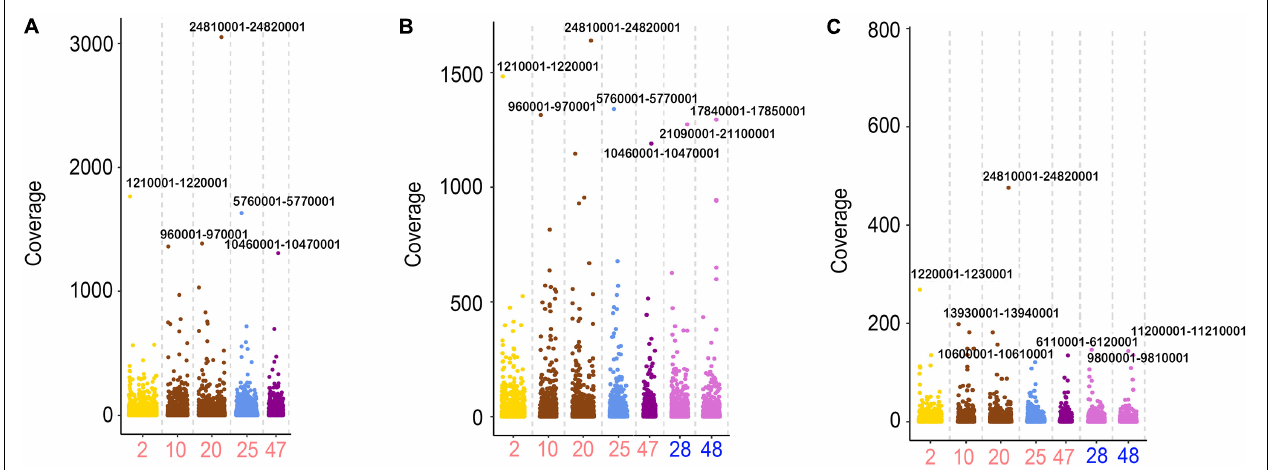
FIGURE 4 | The FPKM distribution of the 10-kb regions from the chromosomes in RCC, 2nF 1 , and 4nAT. (A) Distribution of FPKM from RCC testicular transcriptome in the Chr2, Chr10, Chr20, Chr25, and Chr47 from RCC using the 10-kb region windows. (B) Distribution of FPKM from 2nF 1 testicular transcriptome in the Chr2, Chr10, Chr20, Chr25, and Chr47 from RCC, and Chr28 and Chr48 from CC using the 10-kb region windows. (C) Distribution of FPKM from 4nAT testicular transcriptome in the Chr2, Chr10, Chr20, Chr25, and Chr47 from RCC, and Chr28 and Chr48 from CC using the 10-kb region windows. For each chromosome, the 10-kb regions with the highest FPKM were indicated by the locations. The original data of distribution of the FPKM are shown in Supplementary Table 3